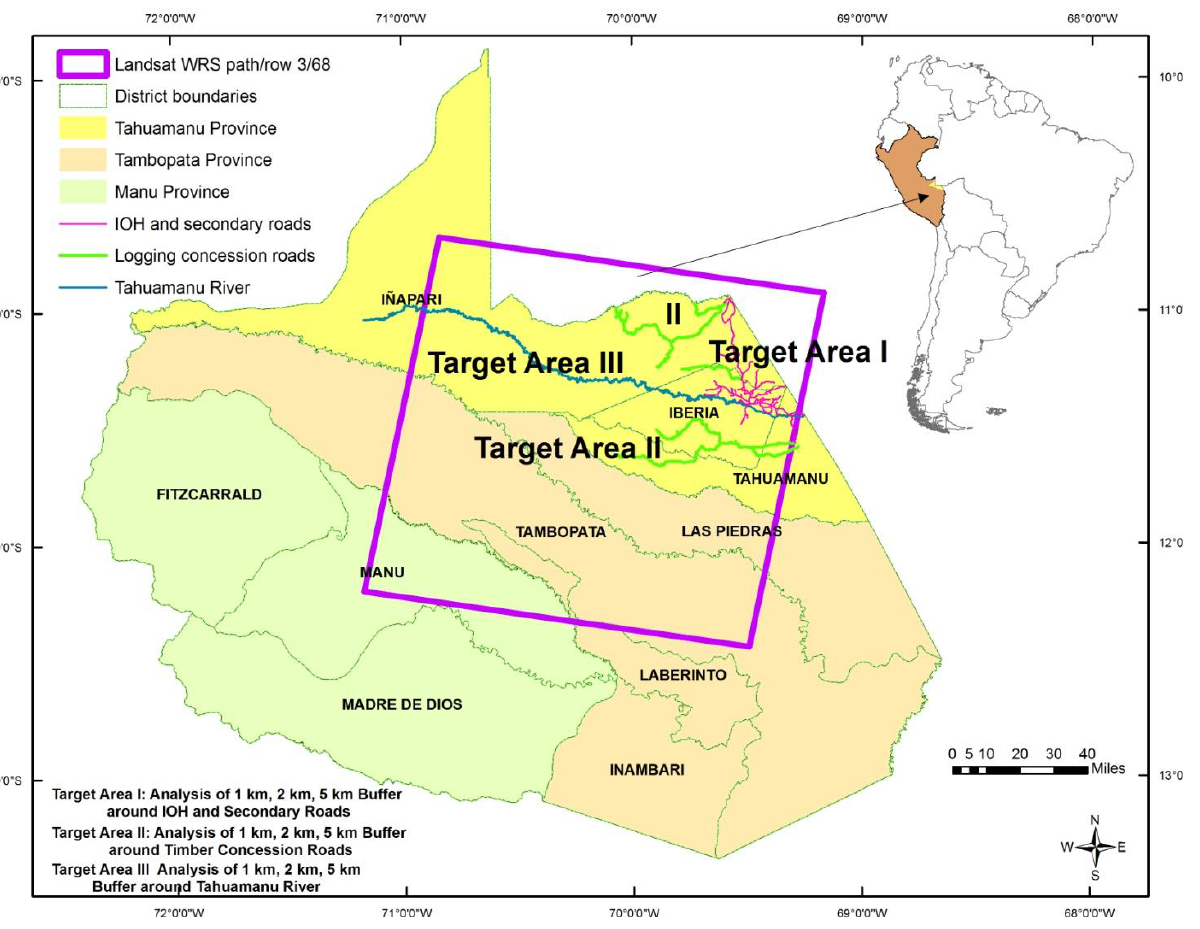
Figure 1. The Province of Tahuamanu (shaded yellow) in Madre de Dios Region showing the three areas where analysis was conducted